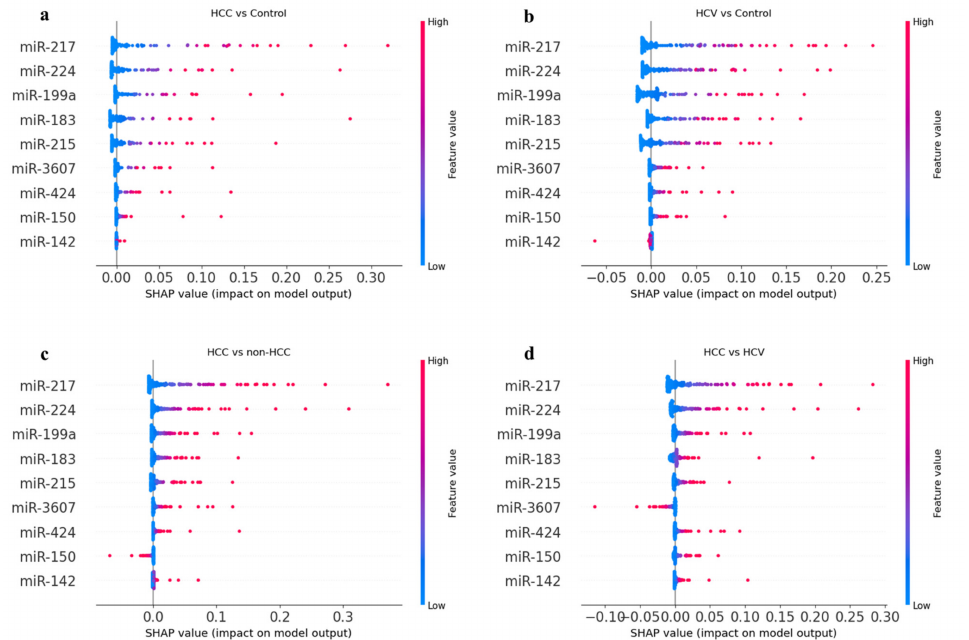
Figure 16. SHAP summary plot describing the impact of target miRNAs on the model output. The higher the SHAP value of a feature, the higher the probability of disease correlation. SHAP values were used to provide consistent and locally accurate attribution values for each miRNA within each prediction model; ( a ) HCC patients compared to healthy individuals, ( b ) HCV infected patients compared to healthy individuals, ( c ) HCC patients compared to non-HCC individuals, and ( d ) HCC compared to HCV infected